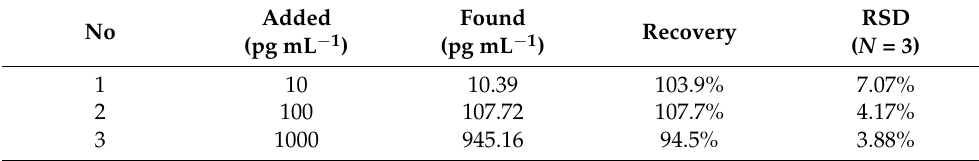
Table 2. Recovery results of the constructed